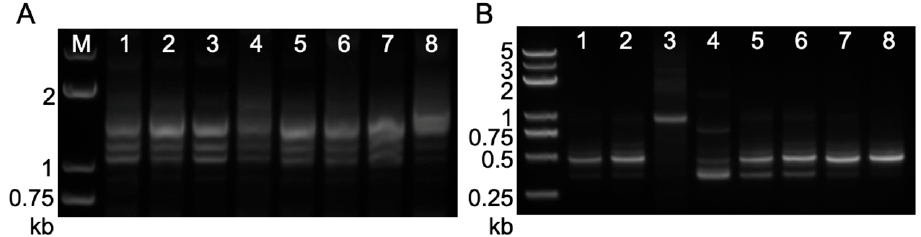
Figure 4. Results of RACE for C1 transcripts from T 2 transgenic leaf tissue. ( A ) 3’ RACE and ( B ) 5 ′ RACE results for the C1 transcript from total RNA extracted from leaf tissue of T 2 transgenic plants. 1, S3-Hel1613; 2, S3-Hel1158; 3, S3-HelA2; 4, S4-Hel1-4; 5, S2-Hel1-4; 6, S3-Hel1-4; 7, S1-Hel1-4; 8, positive C1 transgenic line.